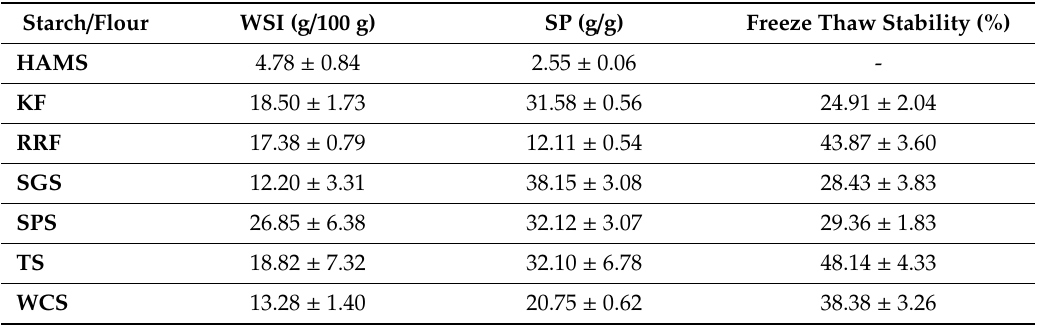
Table 3. The functional properties of the starch and flours (data are means ± standard deviations). Starch / Flour WSI (g / 100 g) SP (g / g) Freeze Thaw Stability